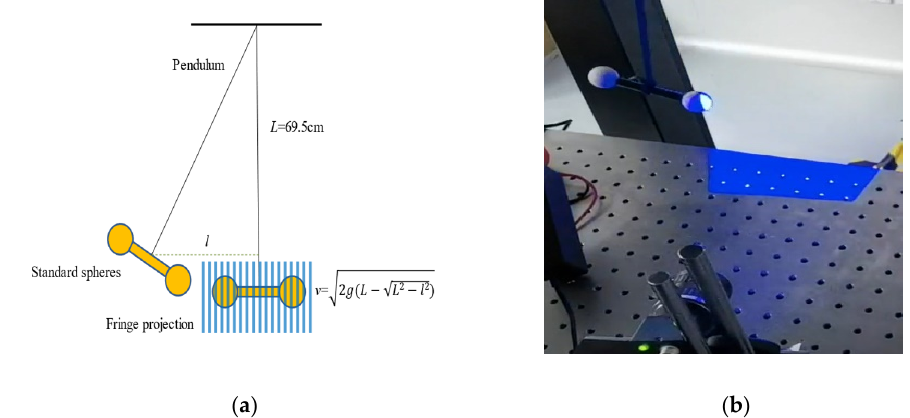
Figure 11. Diagram and dynamic scene of the standard sphere pendulum: ( a ) Diagram of the standard sphere pendulum for dynamic measurement; ( b ) Dynamic scene of the standard sphere pendulum for 3D measurement.